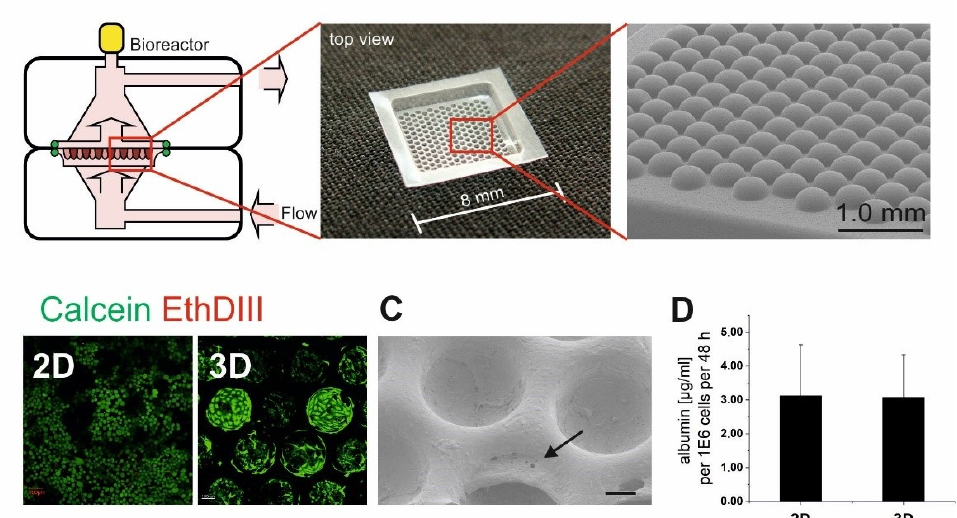
Figure 1. ( A ) schematic illustration of the bioreactor of the culture unit with integrated MatriGrid ® scaffold for 3D culturing, with medium flow direction marked. ( B ) Live/dead staining of 2D (monolayer)- and 3D (MatriGrid ® )-cultured HepaRG cells after 28 days differentiation. Living cells are visualized by calcein dye (green), dead cells by ethidium DIII (red). The scale bar corresponds to 100 µm. ( C ) SEM image of differentiated 3D (MatriGrid ® )-cultured HepaRG cells. The scale bar corresponds to 100 µm. The arrow indicates a membrane-like structure at the top of the cavity. ( D ) Average albumin production (hepatocyte functional marker) of monolayer (2D)- and 3D-cultured HepaRG cells after 28 days differentiation. Mean values ± SE are shown; n = 3.